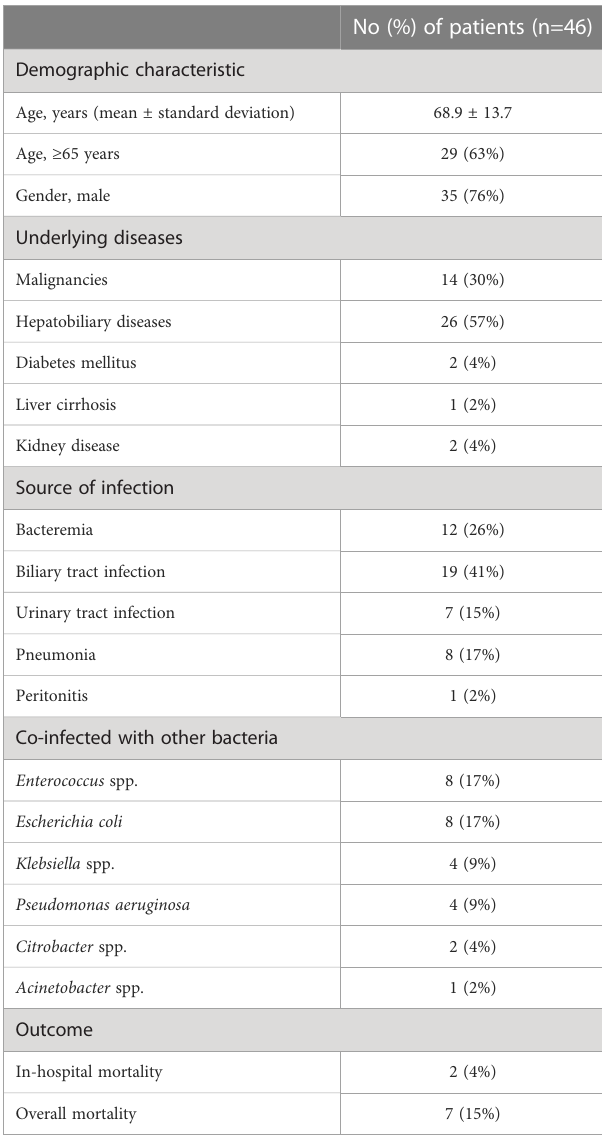
TABLE 1 Epidemiological data of 46 patients with extra-intestinal A. caviae infection from 2017 to 2020. No (%) of patients